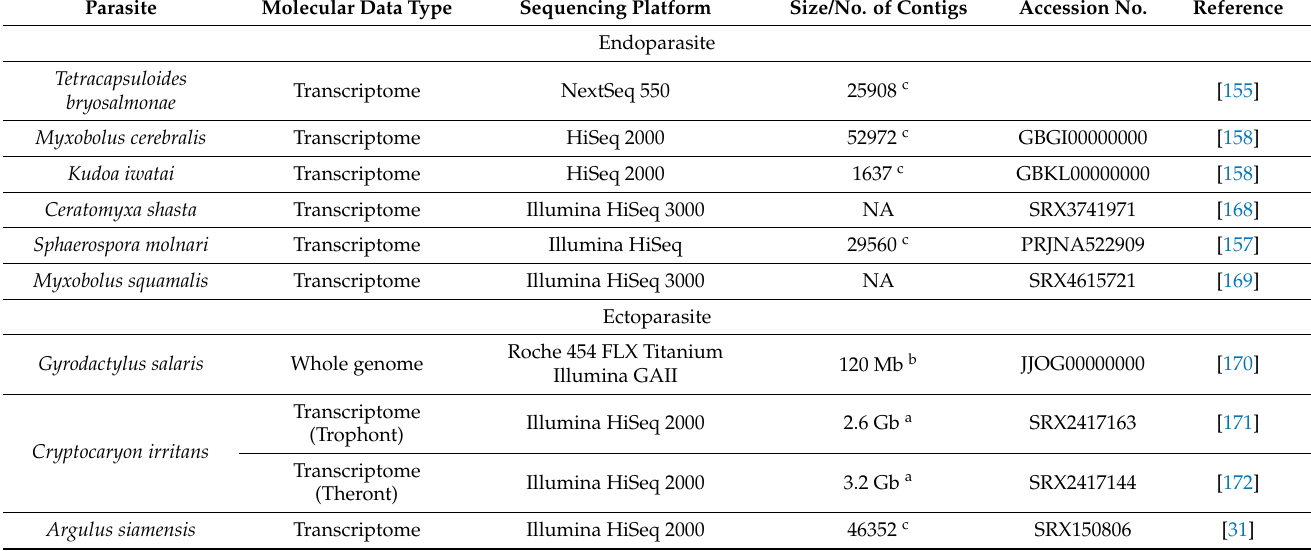
Table 4. Available sequence data for parasites: Table enlists the fish parasites for which genome and transcriptome data are available. a: Transcriptome size, b: Genome size, c: Number of contigs, NA: Not